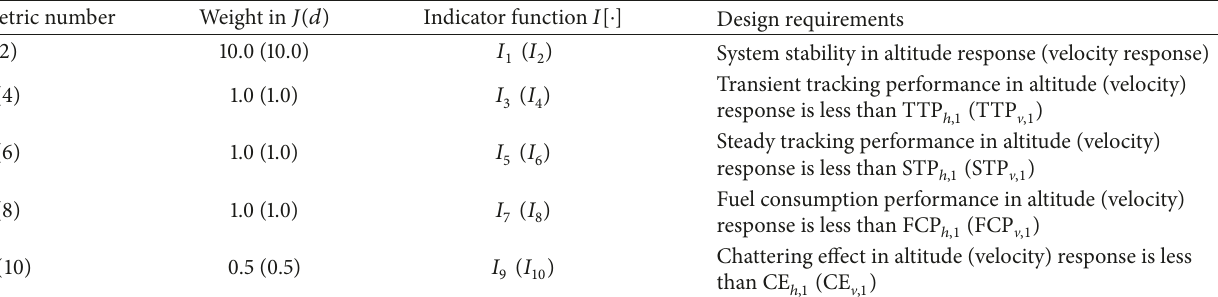
Table 1: Stochastic robustness stability and performance indices of